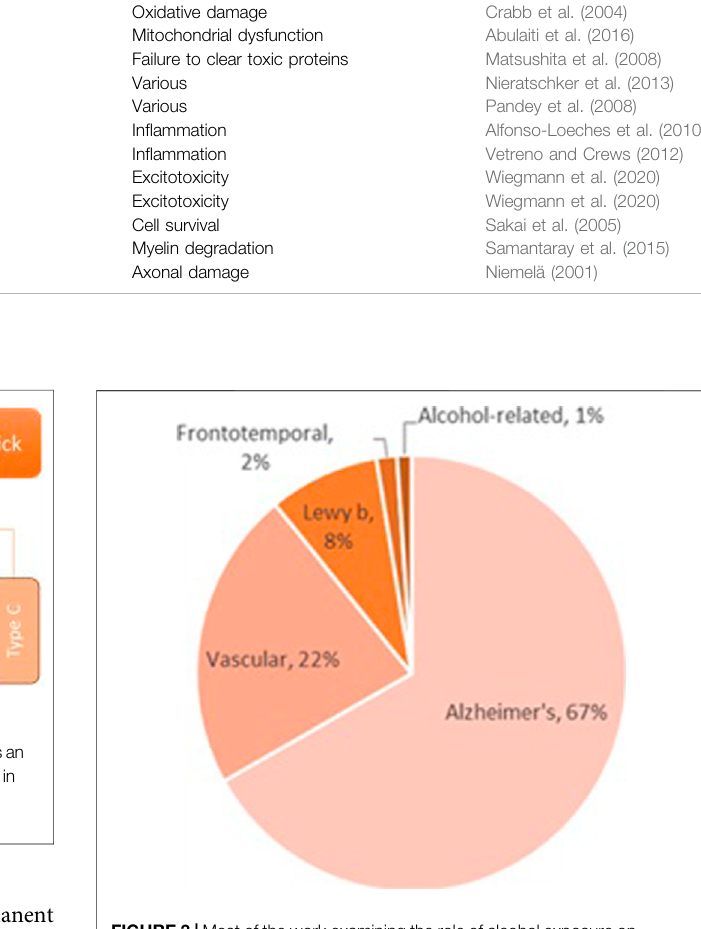
TABLE 1 | Major targets of alcohol that contribute to the pathophysiology of neurodegeneration. Pathway